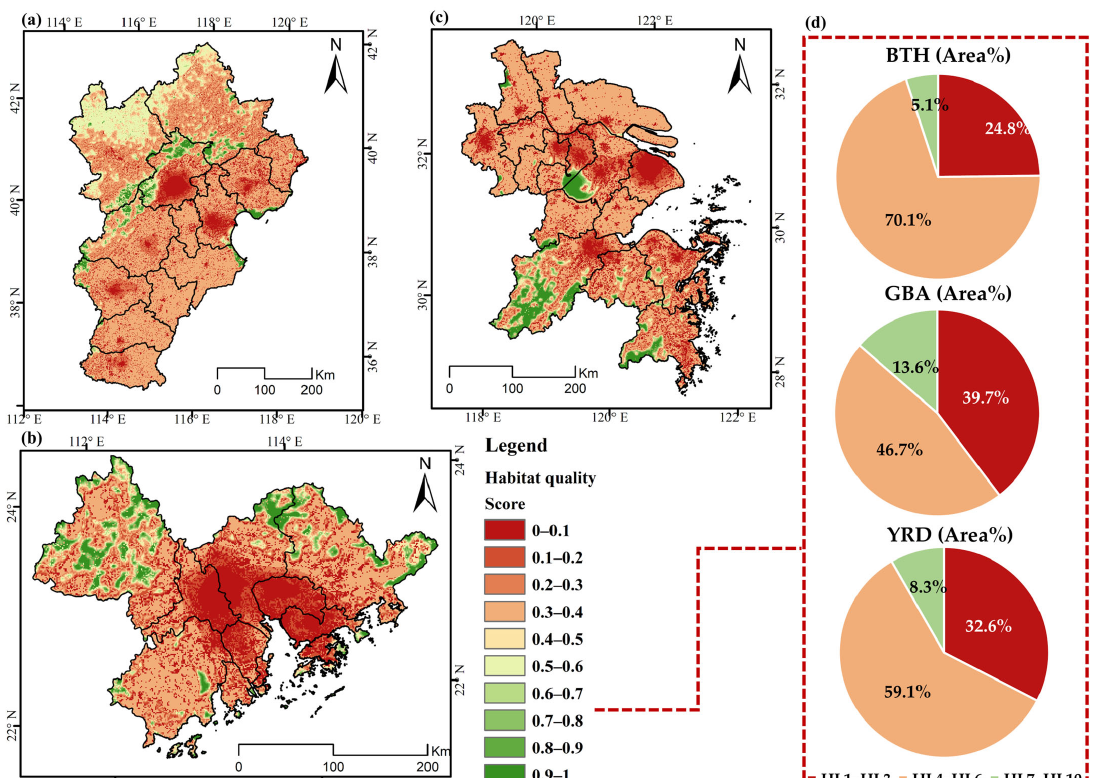
Figure 5. Spatial patterns and distributions of habitat quality in the three UAs: ( a ) BTH, ( b ) GBA, ( c ) YRD, and ( d ) area summary.